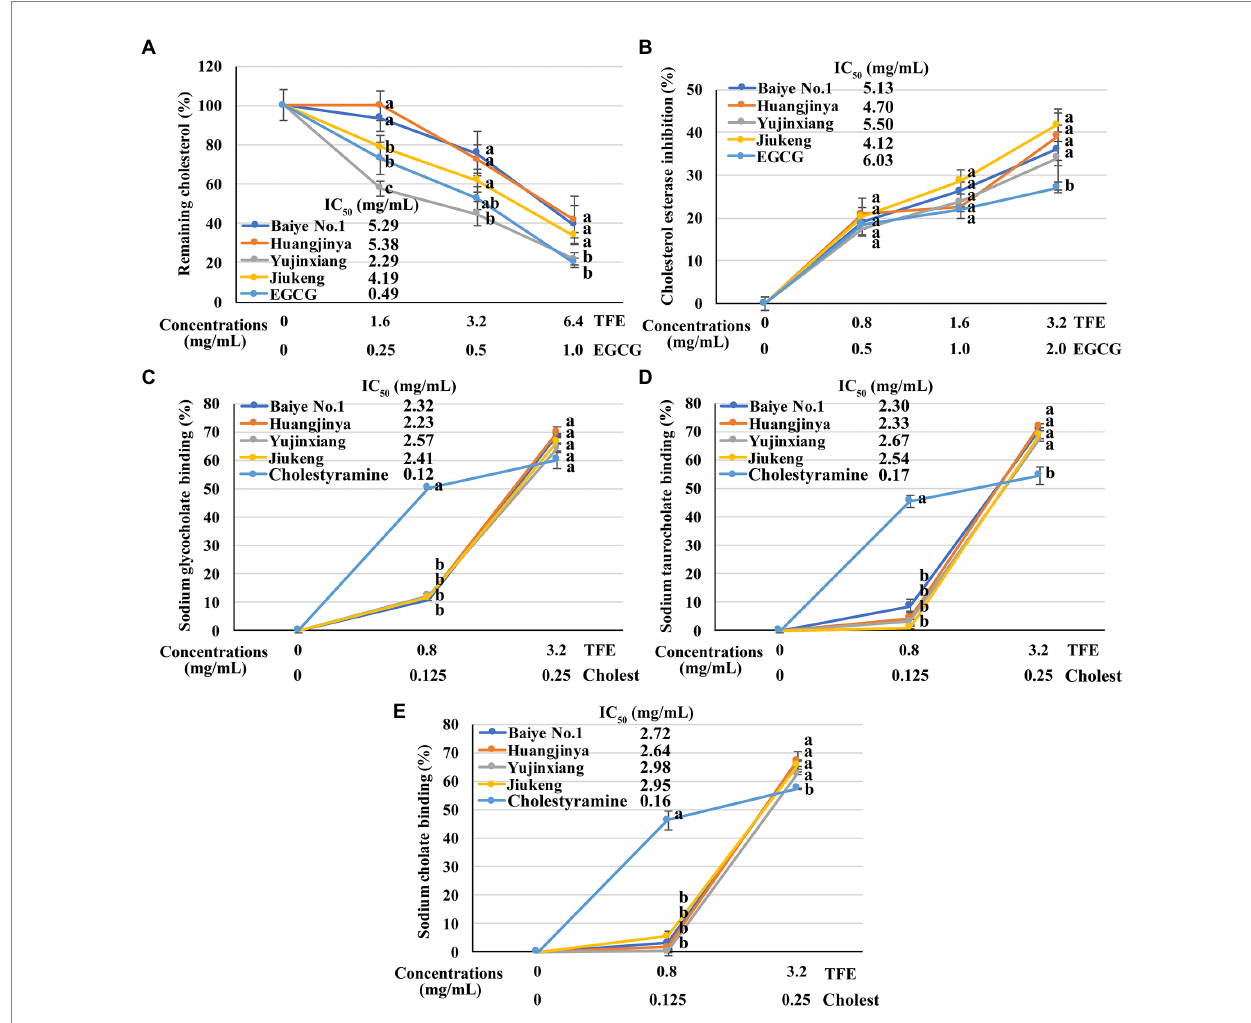
FIGURE 2 The in vitro anti-cholesterol activities of four tea flowers. (A) The activity of decreasing the micellar cholesterol solubility. (B) The cholesterol esterase inhibitory activity. (C–E) The sodium glycocholate (C) , sodium taurocholate (D) , sodium cholate (E) , and binding activity. Epigallocatechin gallate (EGCG) was used as the positive control for the micellar cholesterol solubility assay and cholesterol esterase inhibitory assay. Cholestyramine (Cholest) was used as the positive control for the bile salt binding assays. TFE is short for the tea flower extract. IC 50 is short for the half maximal inhibitory concentration. The same letter within each row indicates no significant difference ( p >